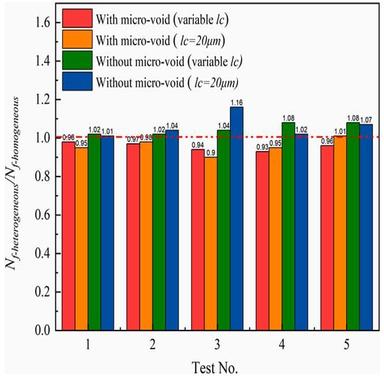
Fretting fatigue lifetime ratio for different tests.